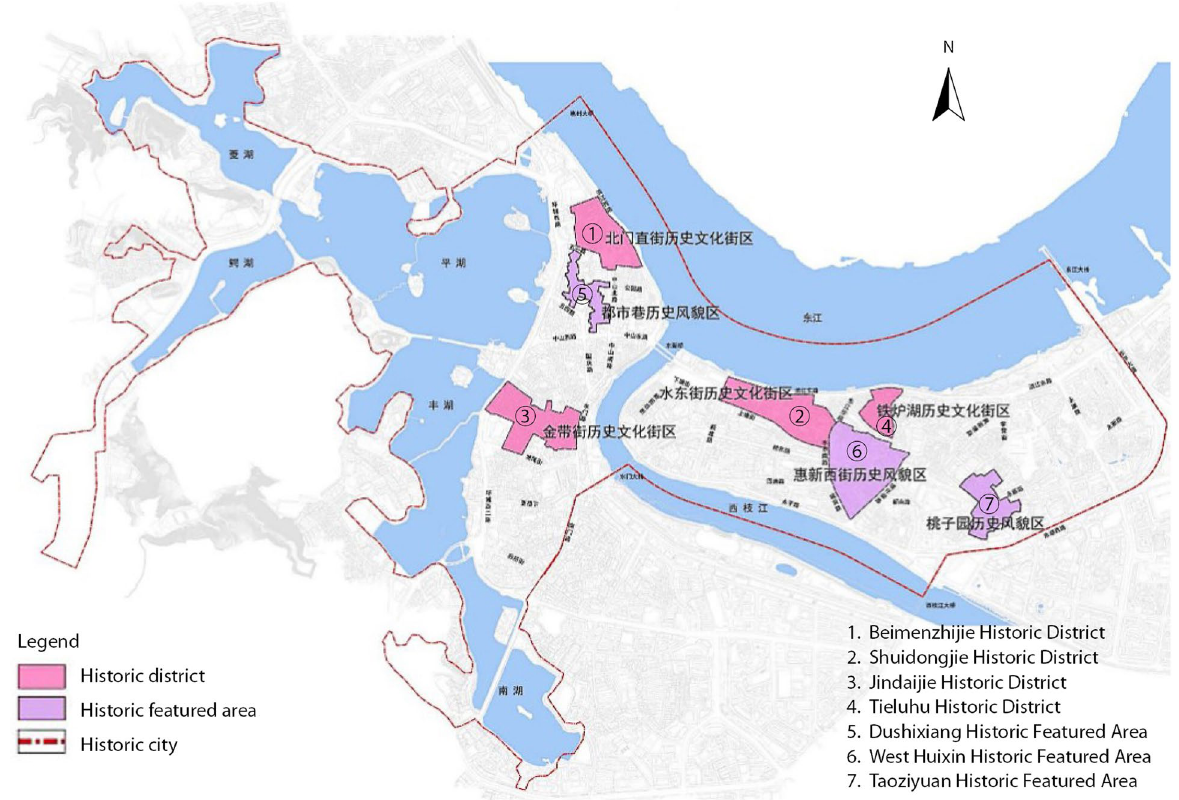
Fig. 1 Map of the Shuidong Quarter in Huicheng District, Huizhou. (Source: An-Design